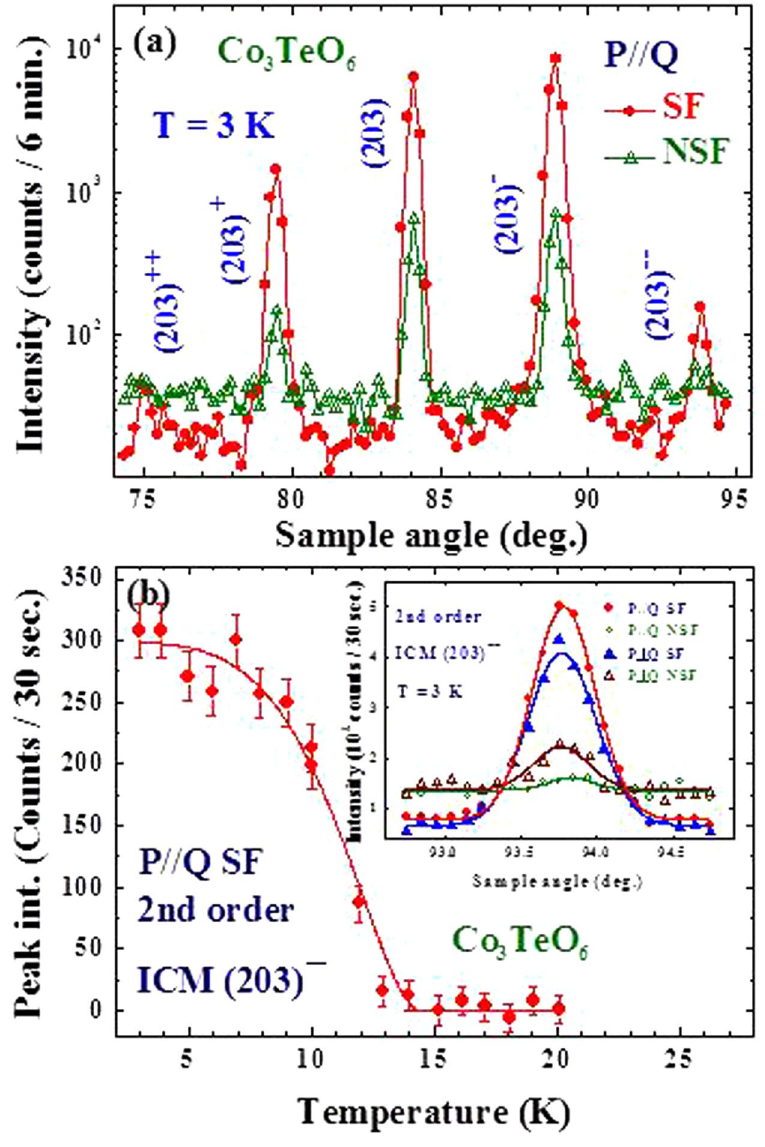
Figure 6. Polarized neutron diffraction measurements for the commensurate and incommensurate Bragg reflections. ( a ) Direct comparison of the spin-flip (SF, filled circles) and non-spin-flip (NSF, open triangles) scans at 3 K, covering two first-order and two second-order satellite reflections associated with the (203) CM magnetic Bragg reflection. Intensity differences between the SF and NSF channels for the five peaks are clearly revealed, showing that all five peaks are magnetic in origin. ( b ) Temperature dependence of the peak intensity of the second-order satellite (203) − 2( q h , 0, q l ) reflection, revealing that these second-order peaks only develop significant intensity below ≈ 15 K (T M4 ). The solid curve is an order-parameter fit to the data to provide a simple guide-to-the-eye. The inset shows the (203) − 2( q h , 0, q l ) reflection taken with four polarization